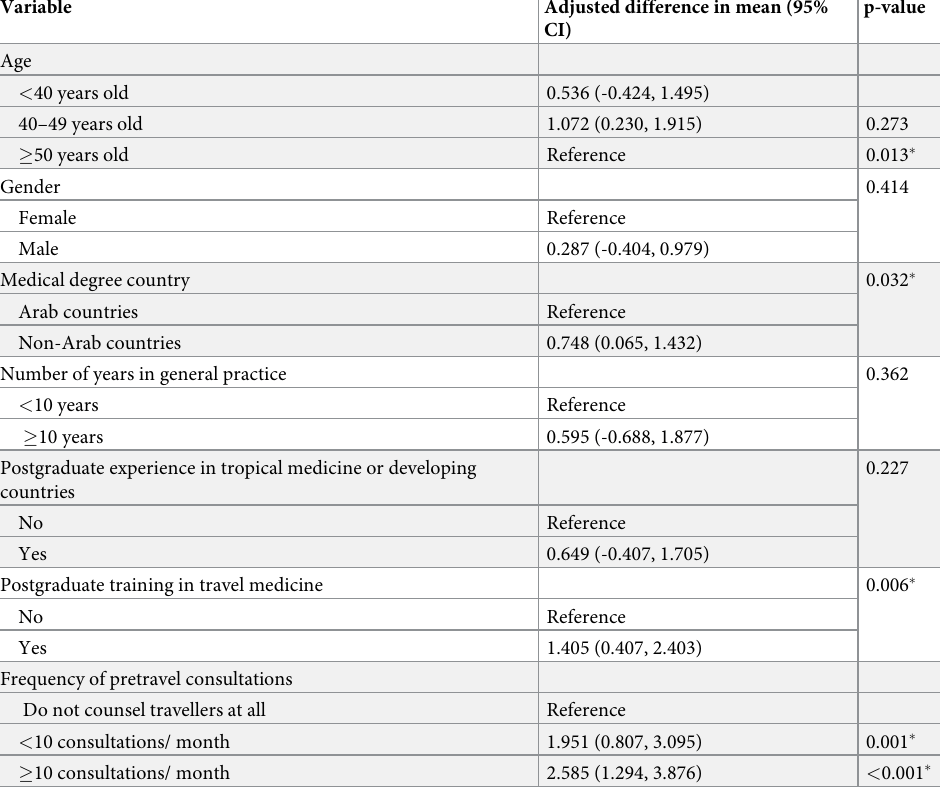
Table 5. Predictors of travel medicine knowledge among primary care physicians (multivariable linear regression analysis) (N =